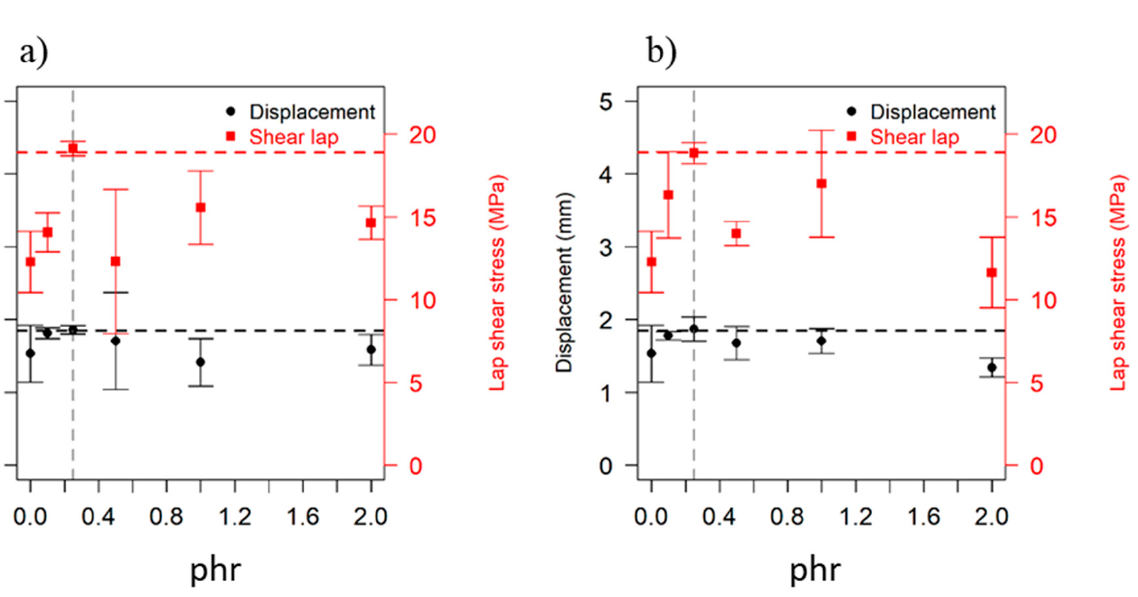
Figure 6. The deconsolidated area during heating the composites for IR welding. Ref. stands for the Elium ® matrix without multifunctional methacrylate monomers.